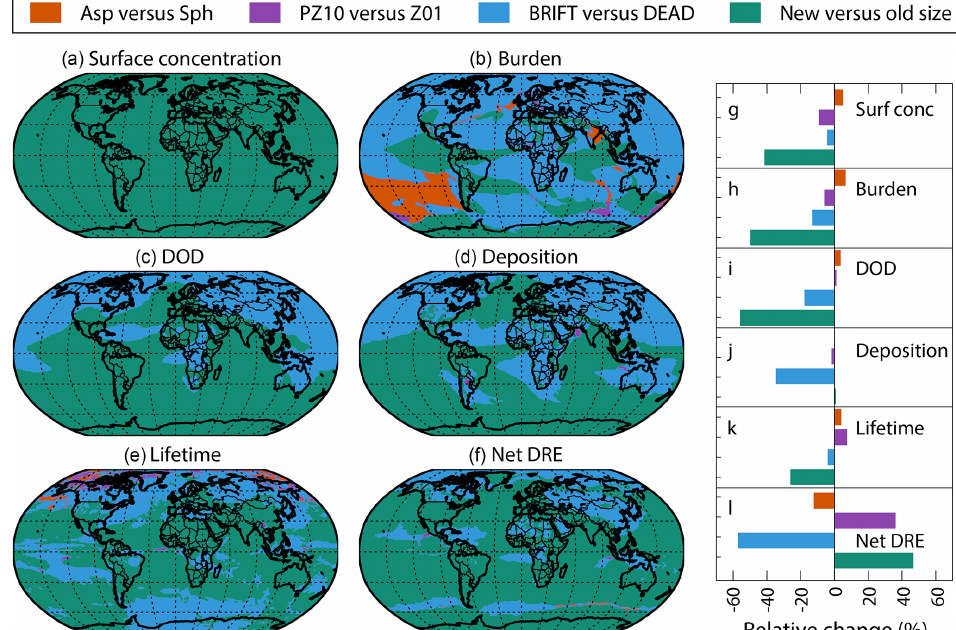
Figure 11. Summary of the relative importance of the modifications (spherical, sph versus non-spherical dust, asp; default dry deposition scheme, Z01 versus new, PZ10; DEAD versus BRIFT dust emission scheme; and coarse-mode size distribution used in CAM5, new size, versus that used in CAM6.1, old size) at grid cell levels (a–f) and in global average (g–i) on surface concentration (a, g) , burden (b, h) ,